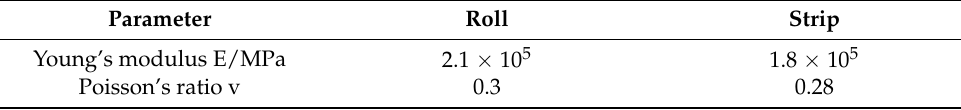
Table 2. Material elastic characteristics.